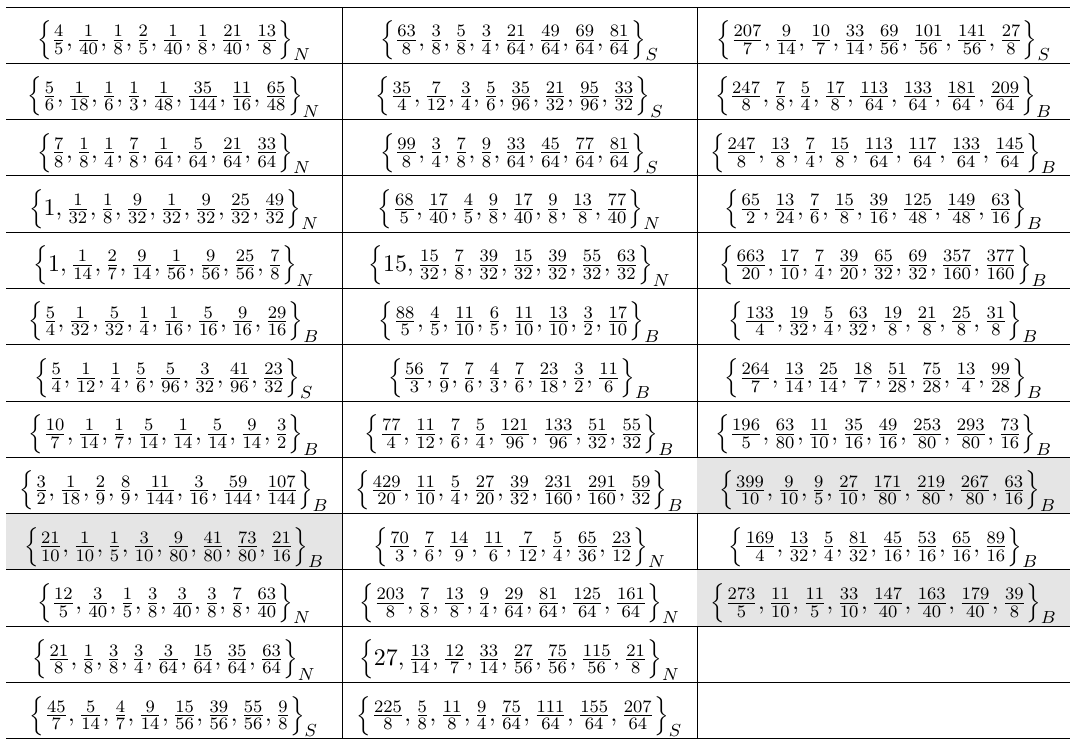
Table 7 . Rank 4 non-degenerate unitary theories with ‘ = 0 . Type: S=SUSY, B=SUSY Broken, N = non-SUSY. We highlight the theories that are a product of lower rank